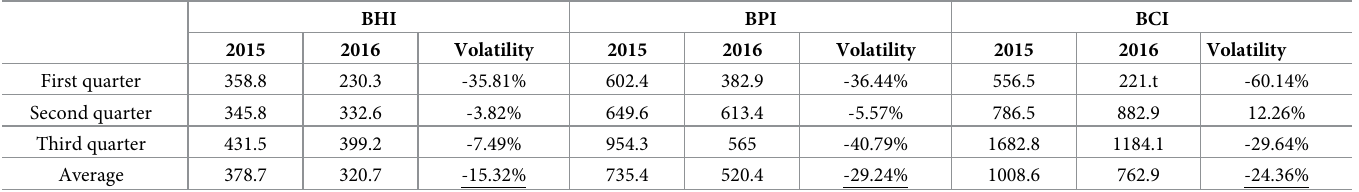
Table 11. Comparison of market performance of different ship types before and after the Zika virus epidemic. BHI BPI